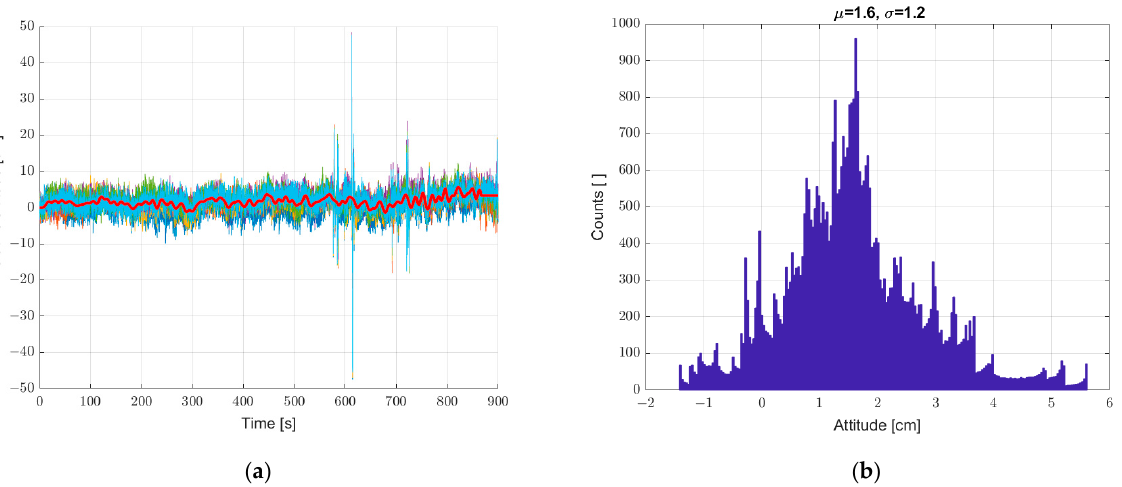
Figure 9. ( a ) Graph over time with 6 + 1, bold graph calculated from data averaged and filtered with a low-pass IIR filter, and ( b ) histogram. Static measurements—sensor array at standstill.